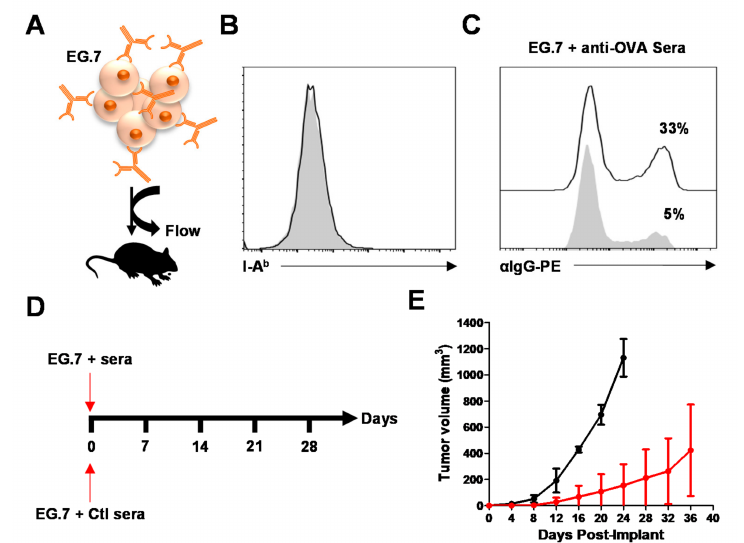
Figure 4. The neutralizing effects of generated sera on in vitro antigen presentation. ( A ) Schematic representation of the antigen presentation assay conducted in the presence of antibodies from immunized mice. Antibodies were added 1 h following OVA pulsing. ( B ) Quantification of IL-2 produced by OTII-derived CD4 T cells during the antigen presentation assay shown in panel ( A ). ( C ) Schematic representation of the antigen presentation assay conducted using OVA admixed with antibodies generated by immunized mice prior to MSC-IPr pulsing. ( D ) Quantification of IL-2 produced by OTII-derived CD4 T cells during the antigen presentation assay shown in panel ( C ). For panels ( B , D ), n = 6/group with * p < 0.05 and *** p < 0.001.